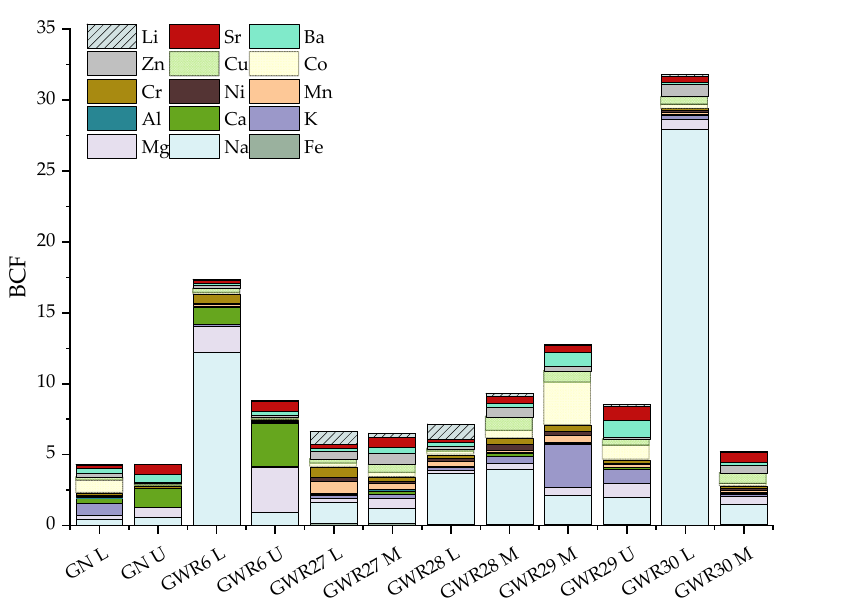
Figure 6. Bioconcentration factor (BCF) of macro- and microelements in plant species ( Lolium sp.—L, Urtica sp.—U, and Mentha sp.—M) in Banat (GN, GWR6) and Dobrogea (GWR27, GWR28, GWR29, and GWR30) region.